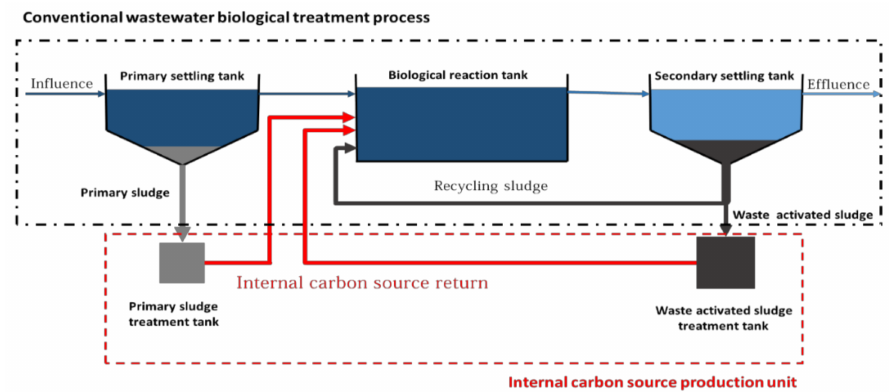
Figure 2. Conventional biological wastewater biological treatment process with an internal carbon source production